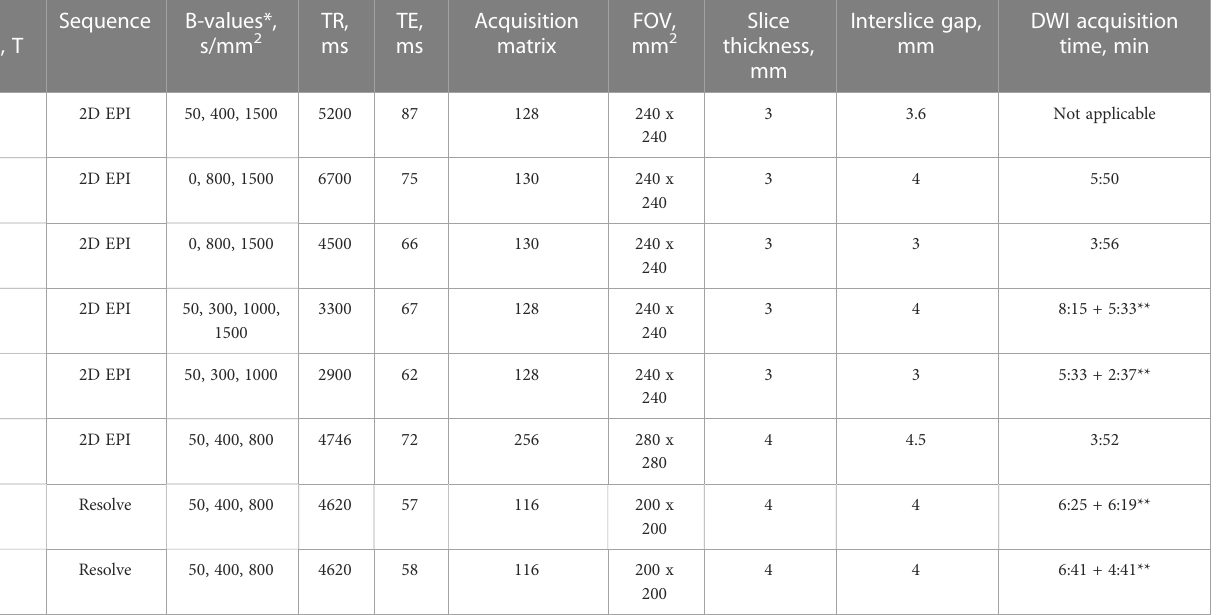
TABLE 2 Overview of scanners and diffusion-weighted imaging (DWI) acquisition